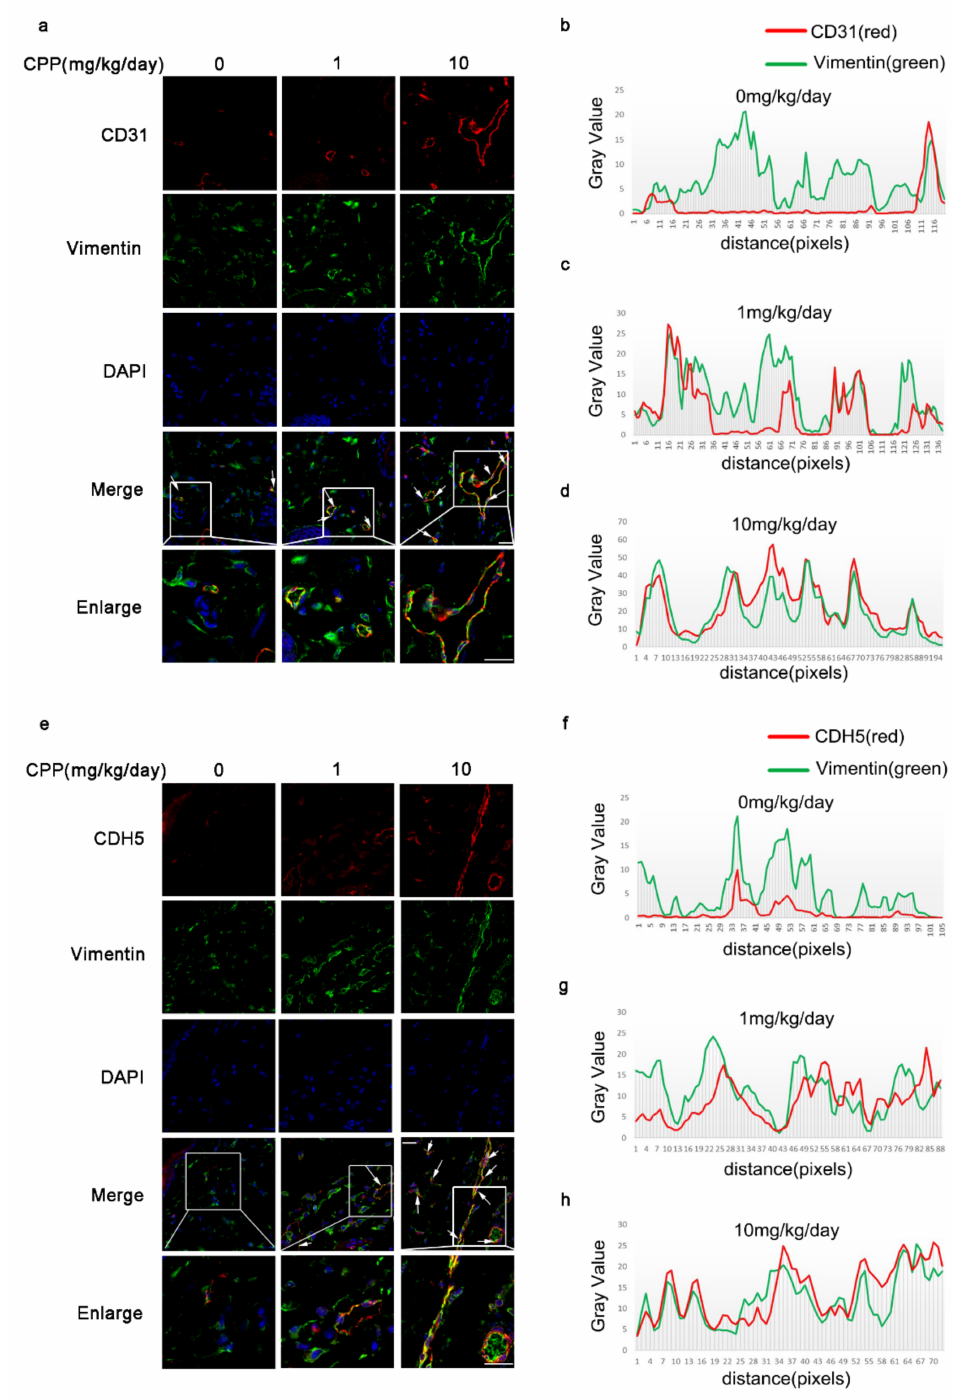
Figure 10. CPP increased the protein levels of CD31 and CDH5 in HDFs in vivo. ( a ) and ( e ): After two weeks of continuous intraperitoneal injection of mice with different concentrations (1 mg/kg/day, 10 mg/kg/day) of CPP and PBS, paraffin sections from mouse dorsal skin were performed, and immunofluorescence was conducted to detect the co-localization of CD31 and Vimentin or CDH5 and Vimentin. White arrows indicate cells expressing both Vimentin and HEY1. Scale bars: 100 µ m. ( b – d ) and ( f – h ): ImageJ analysis the co-localization of different